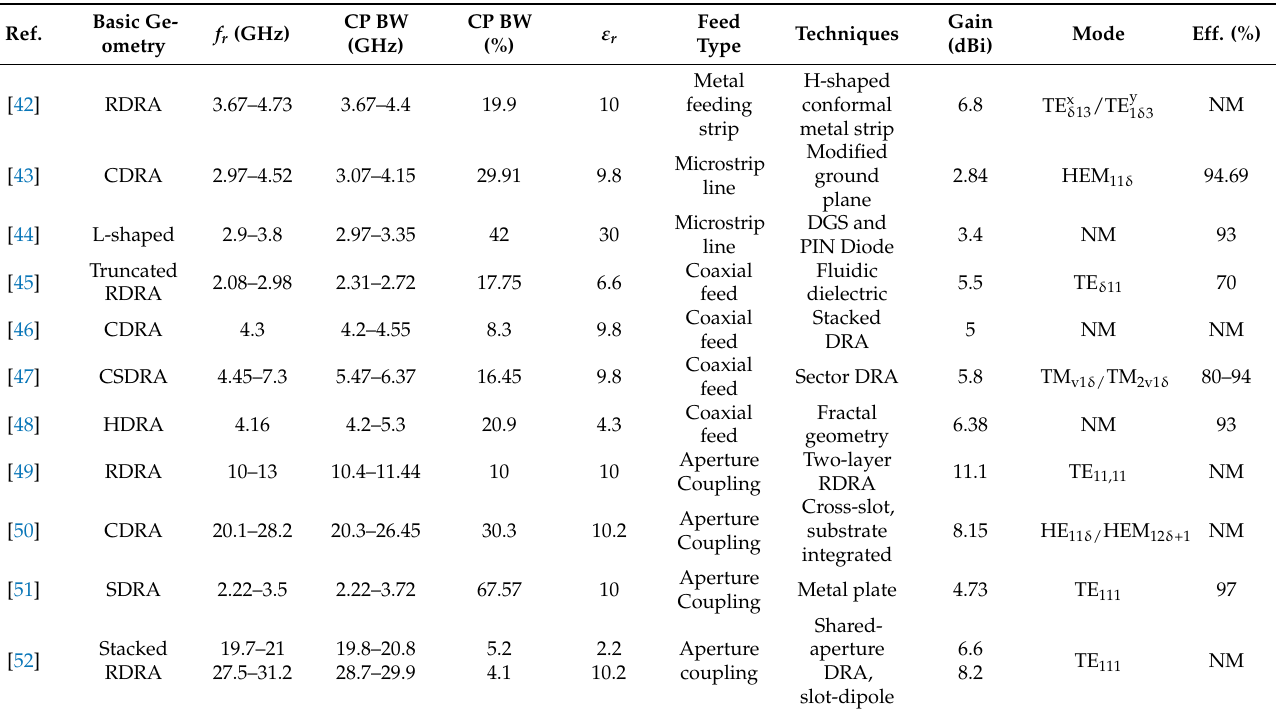
Table 2. Comparison between different single-fed circularly polarized